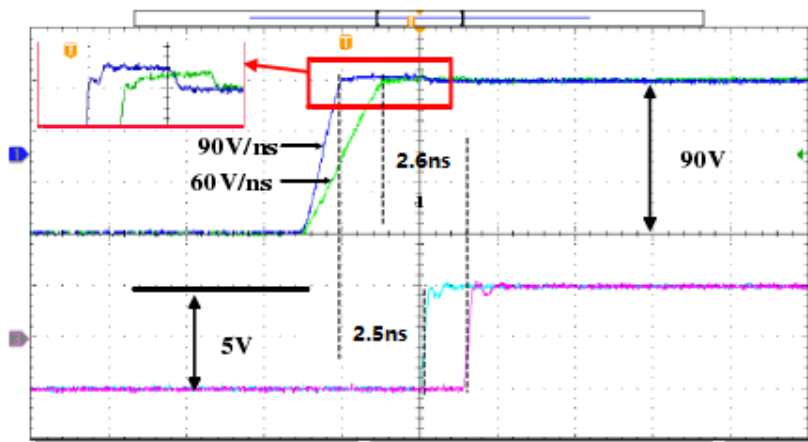
Figure 14. High-side test results.